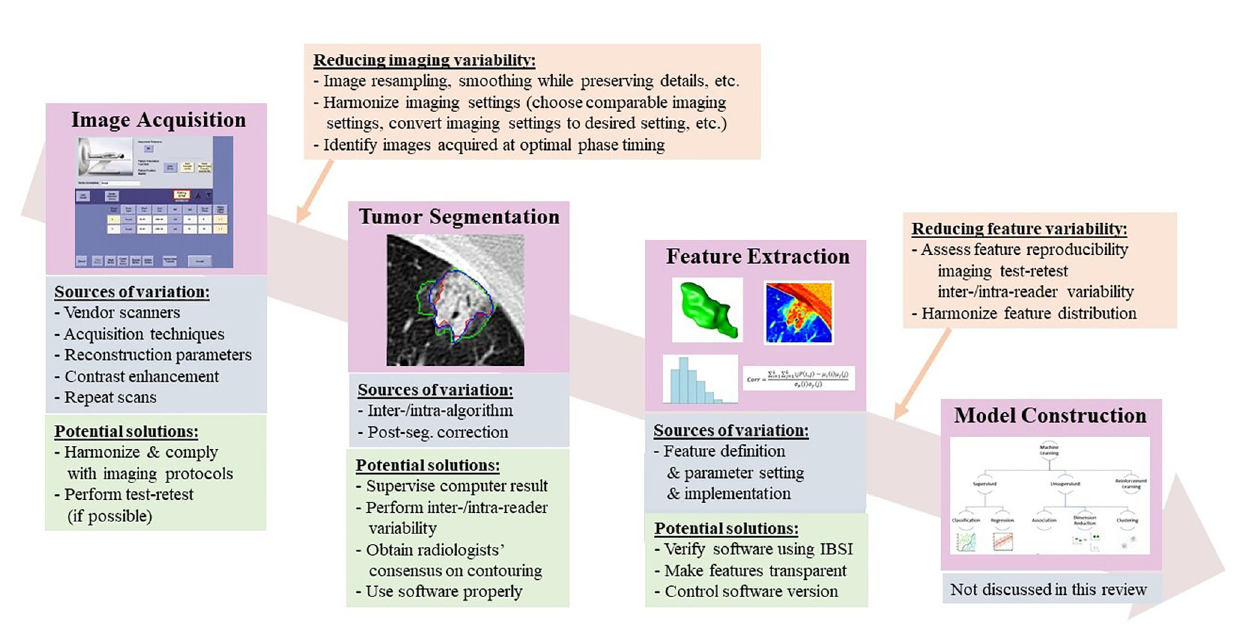
FIGURE 1 | Radiomics work fl ow, along with sources of variation and potential strategies to reduce feature